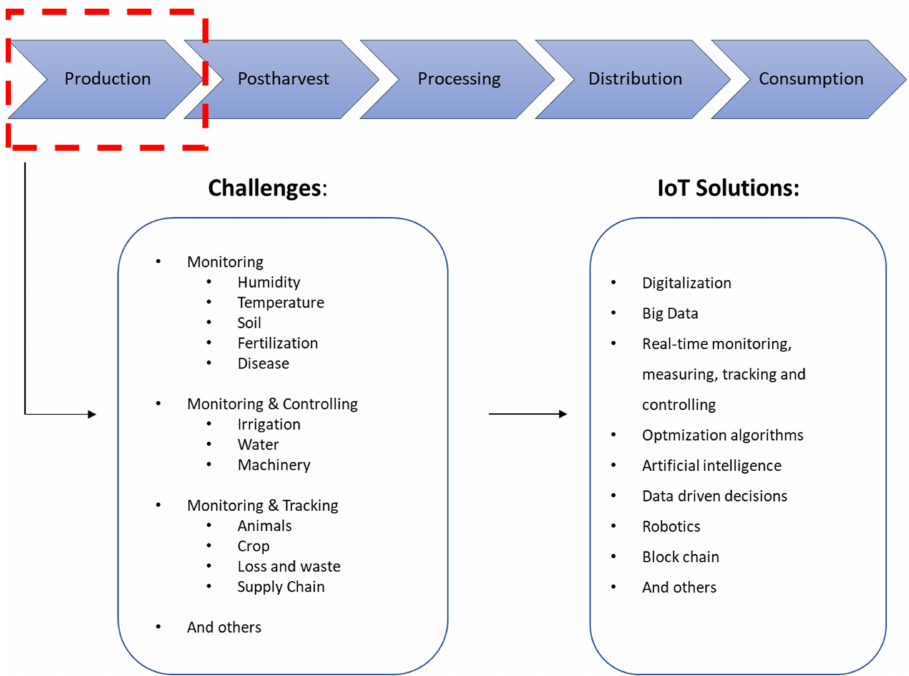
Figure 1. Main challenges and IoT